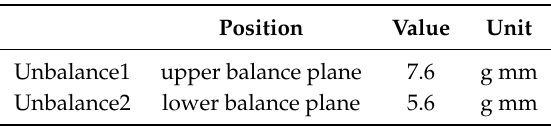
Table 4. Verification